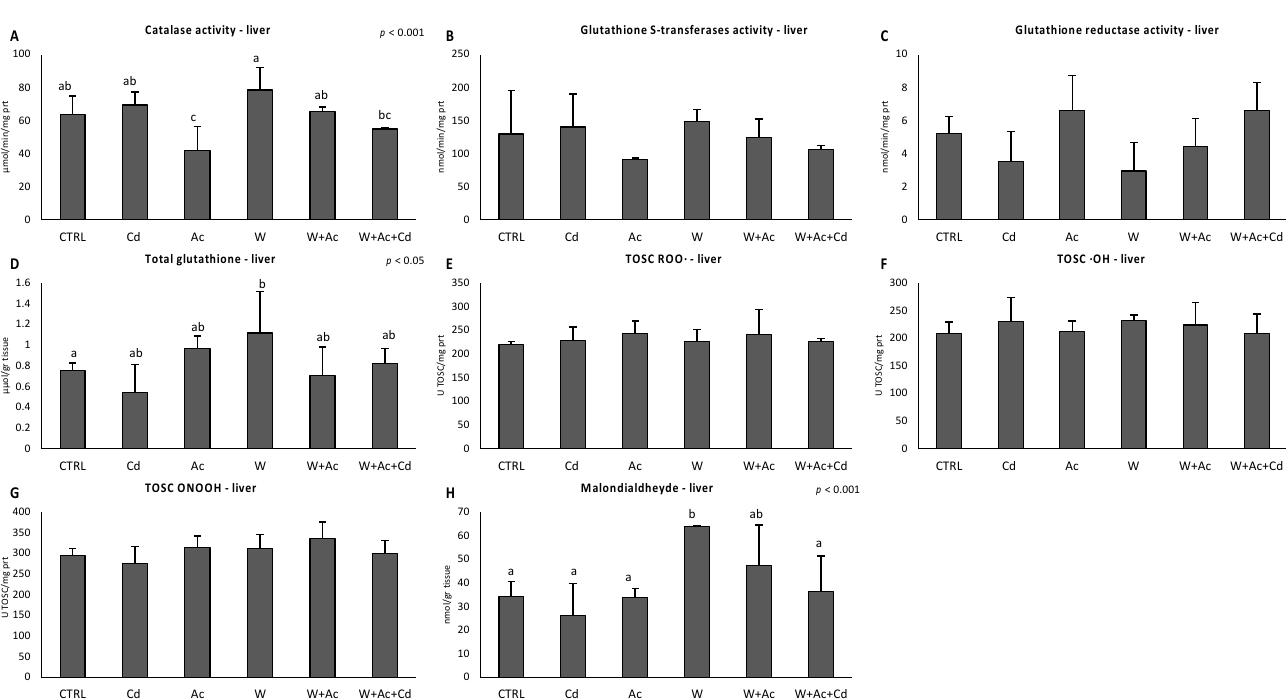
Figure 5. Activities of individual antioxidant enzymes ( A – C ) and total glutathione concentration ( D ), Total Oxyradical Scavenging Capacity toward peroxyl and hydroxyl radicals and peroxynitrite ( E , TOSC ROO • , F , TOSC HO • and G , TOSC ONOOH, respectively), and malondialdehyde content ( H ) in liver of T. bernacchii exposed to different experimental conditions. Different letters highlight significant differences between groups of means. Data are expressed as mean ± standard deviations, n = 5.